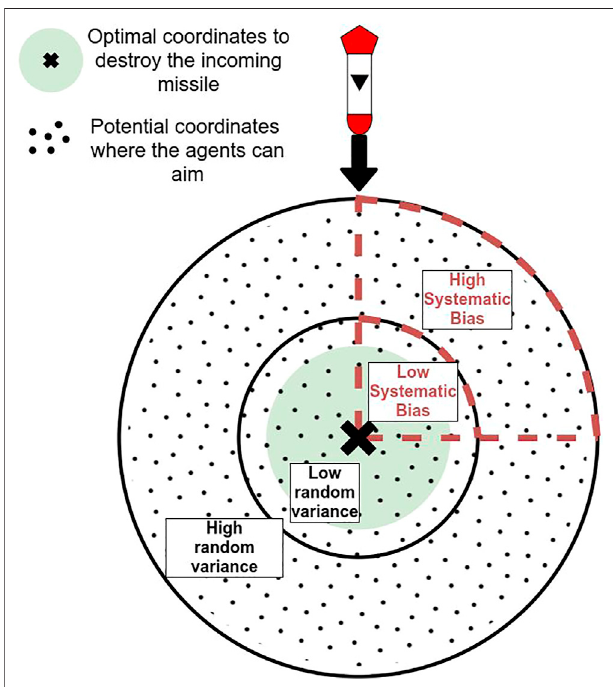
FIGURE 3 | Visualization of the different biases applied to the agents in the study (not to scale). The greater the bias, the lower the accuracy of the agent. For the systematic bias, a “ quadrant ” is randomly chosen for each participant at the beginning of a session. Low systematic bias and low random variance or high systematic bias and high random variance result in the same performance output.